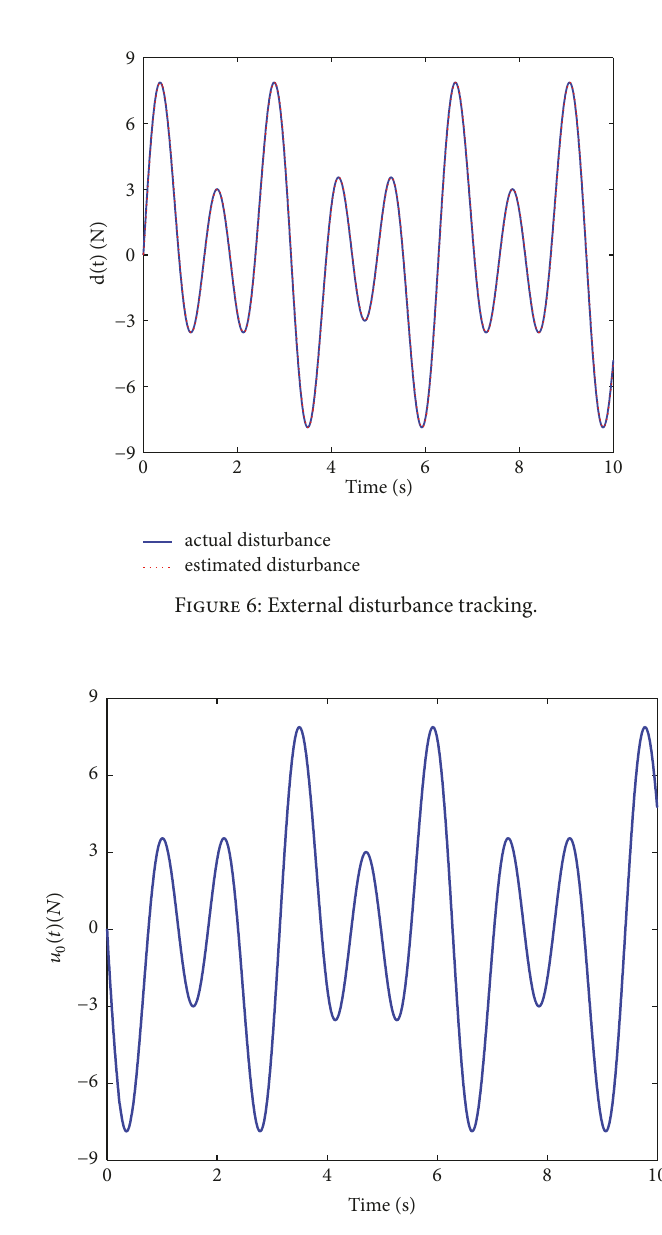
Figure 7: Designed control command 𝑢 0 (𝑡)